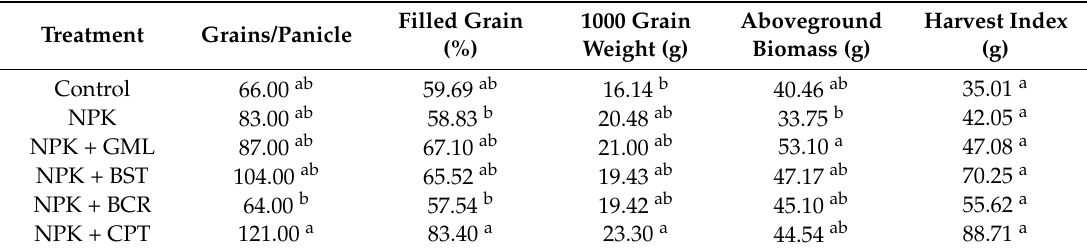
Table 3. Effect of soil amendment on rice yield and its